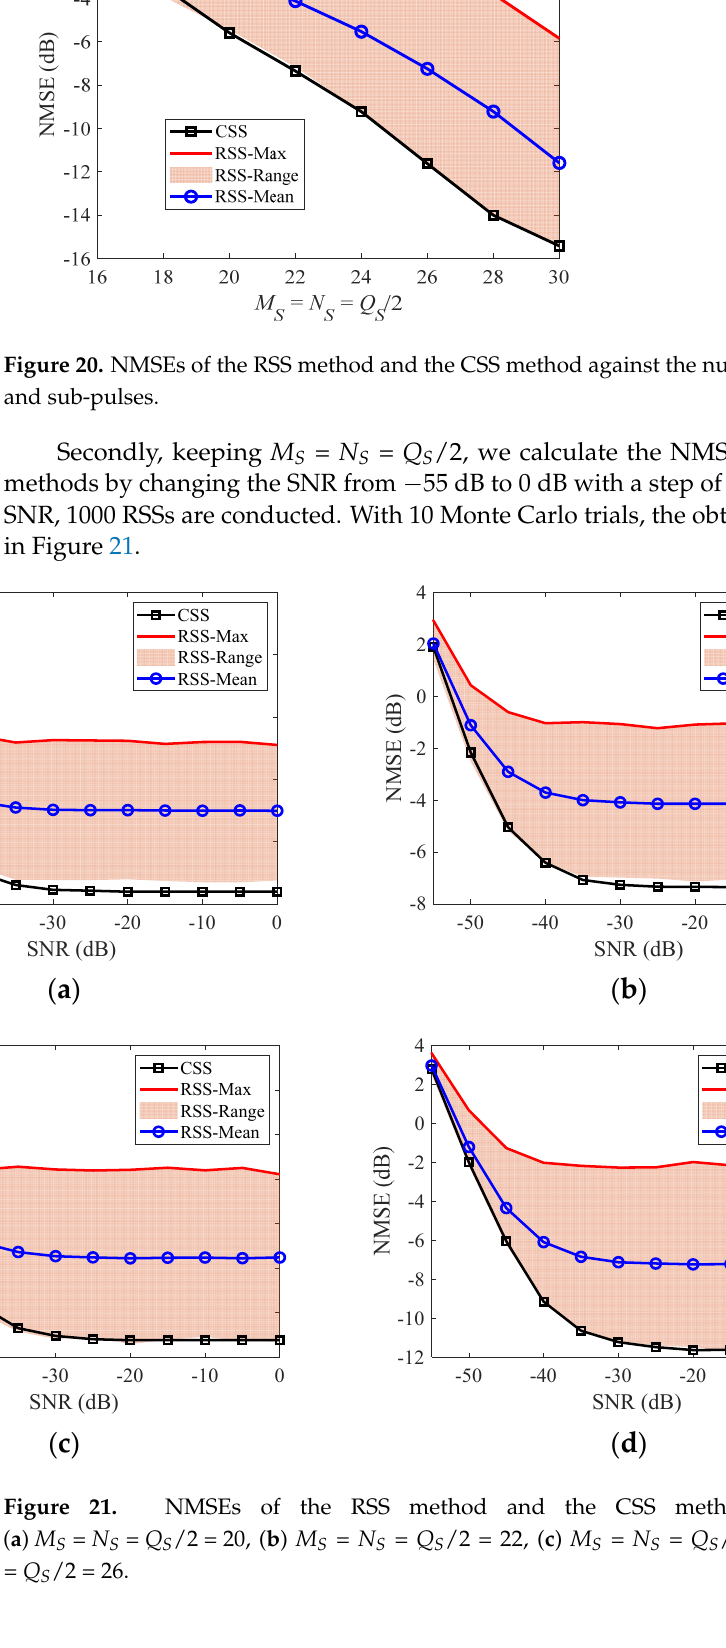
22 of 35 Figure 18. Target imaging result obtained by TSL0 with random sparse-sampled signal cube. Figure 19. Target imaging result obtained by TSL0 with cognitive sparse-sampled signal cube. It should be noted that Figure 18 only shows one imaging example of the RSS method. Considering its randomness, the RSS method can actually obtain higher imaging performance than that shown in Figure 18. In order to fairly compare the RSS method and the CSS method, two additional simulations are conducted.